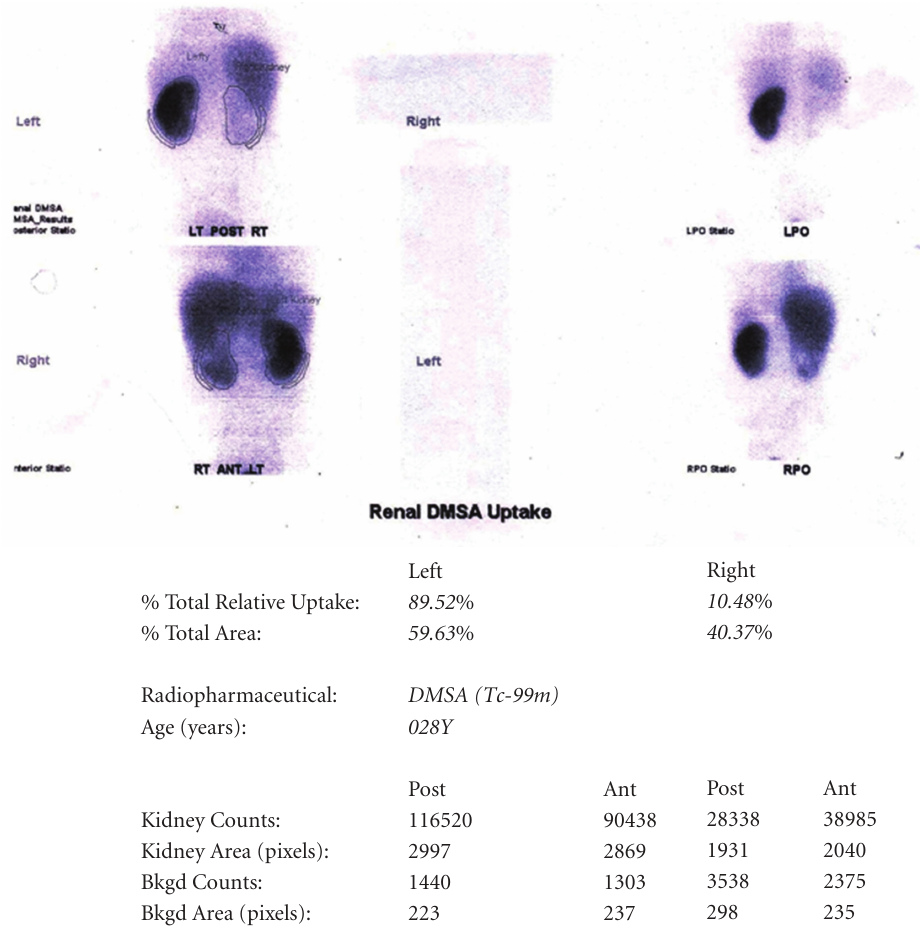
Figure 1: DMSA scan showing a poorly functioning right kidney.